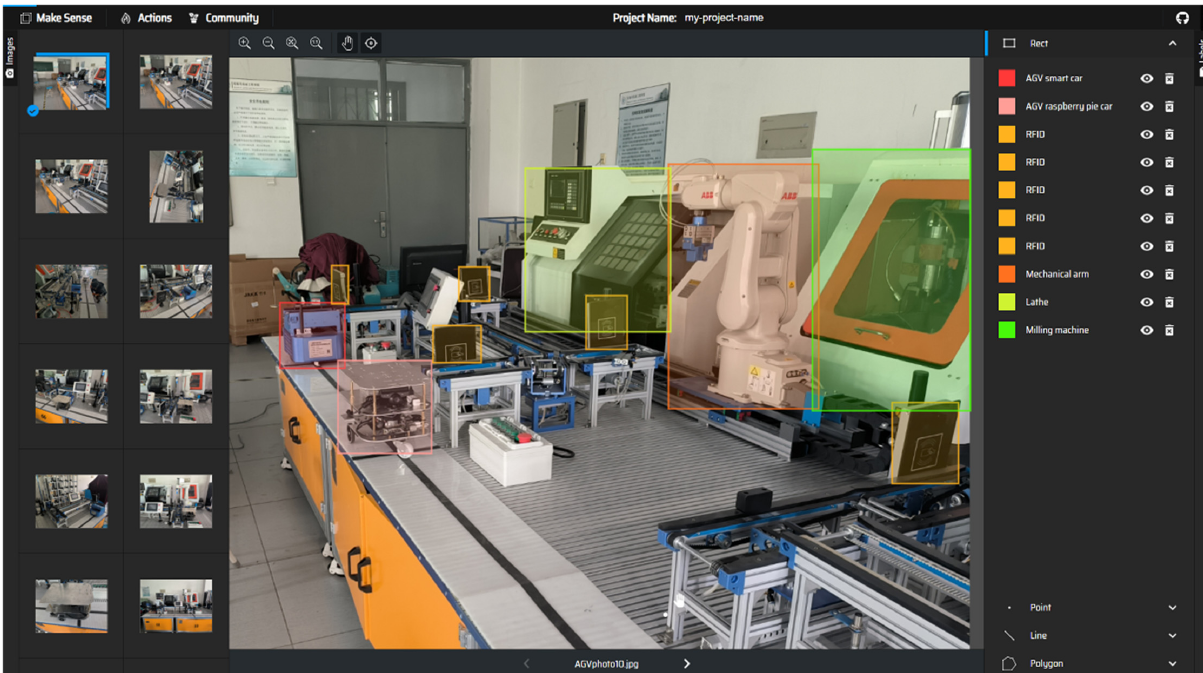
Figure 6. The dataset labeling process.